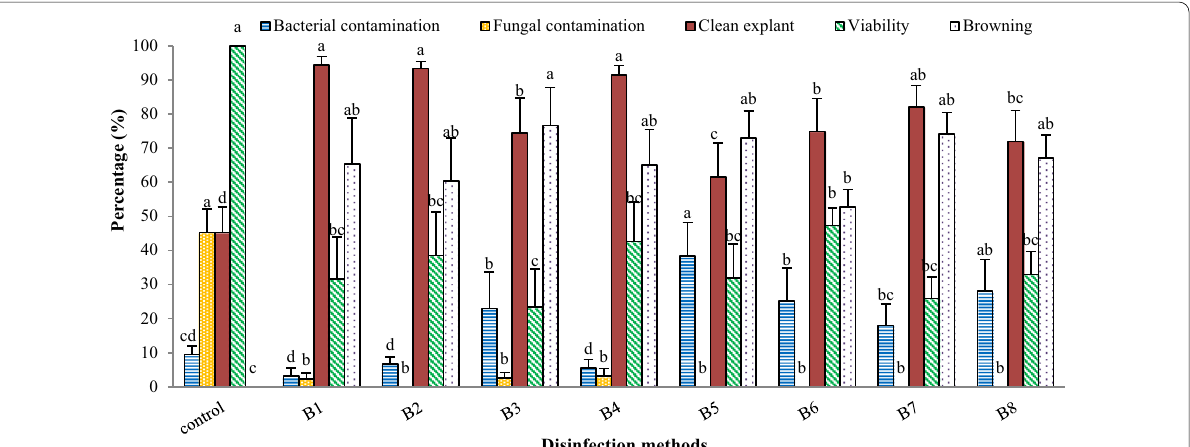
Fig. 2 The effect of different disinfection methods and inclusion of benomyl in culture medium on the bacterial contamination and in vitro response of M. azedarach L. leaf explants. Bars with different letters indicate a significant difference ( P Tests